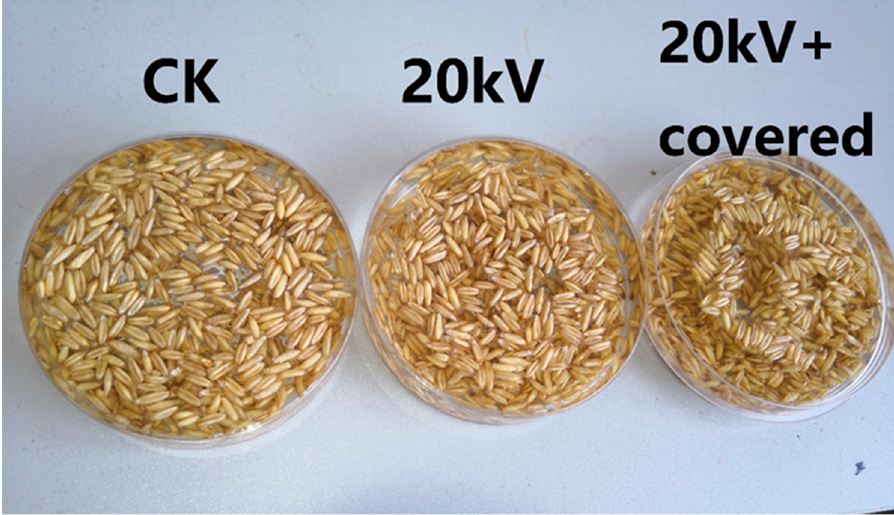
Figure 3. Hydrophilic changes of naked oat seeds after HVEF treatment.